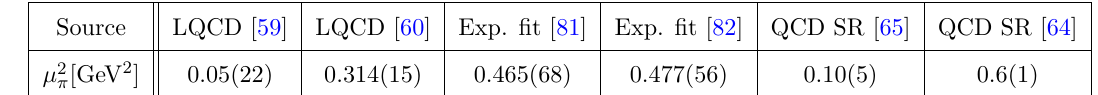
Table 11 . Different determinations of µ 2